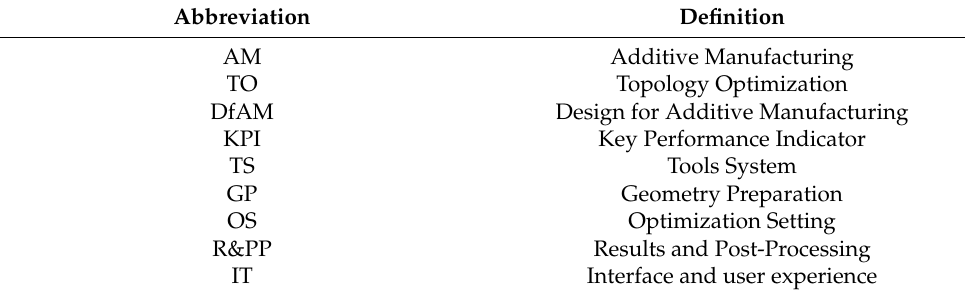
Table 1. List of abbreviations and acronyms used in the